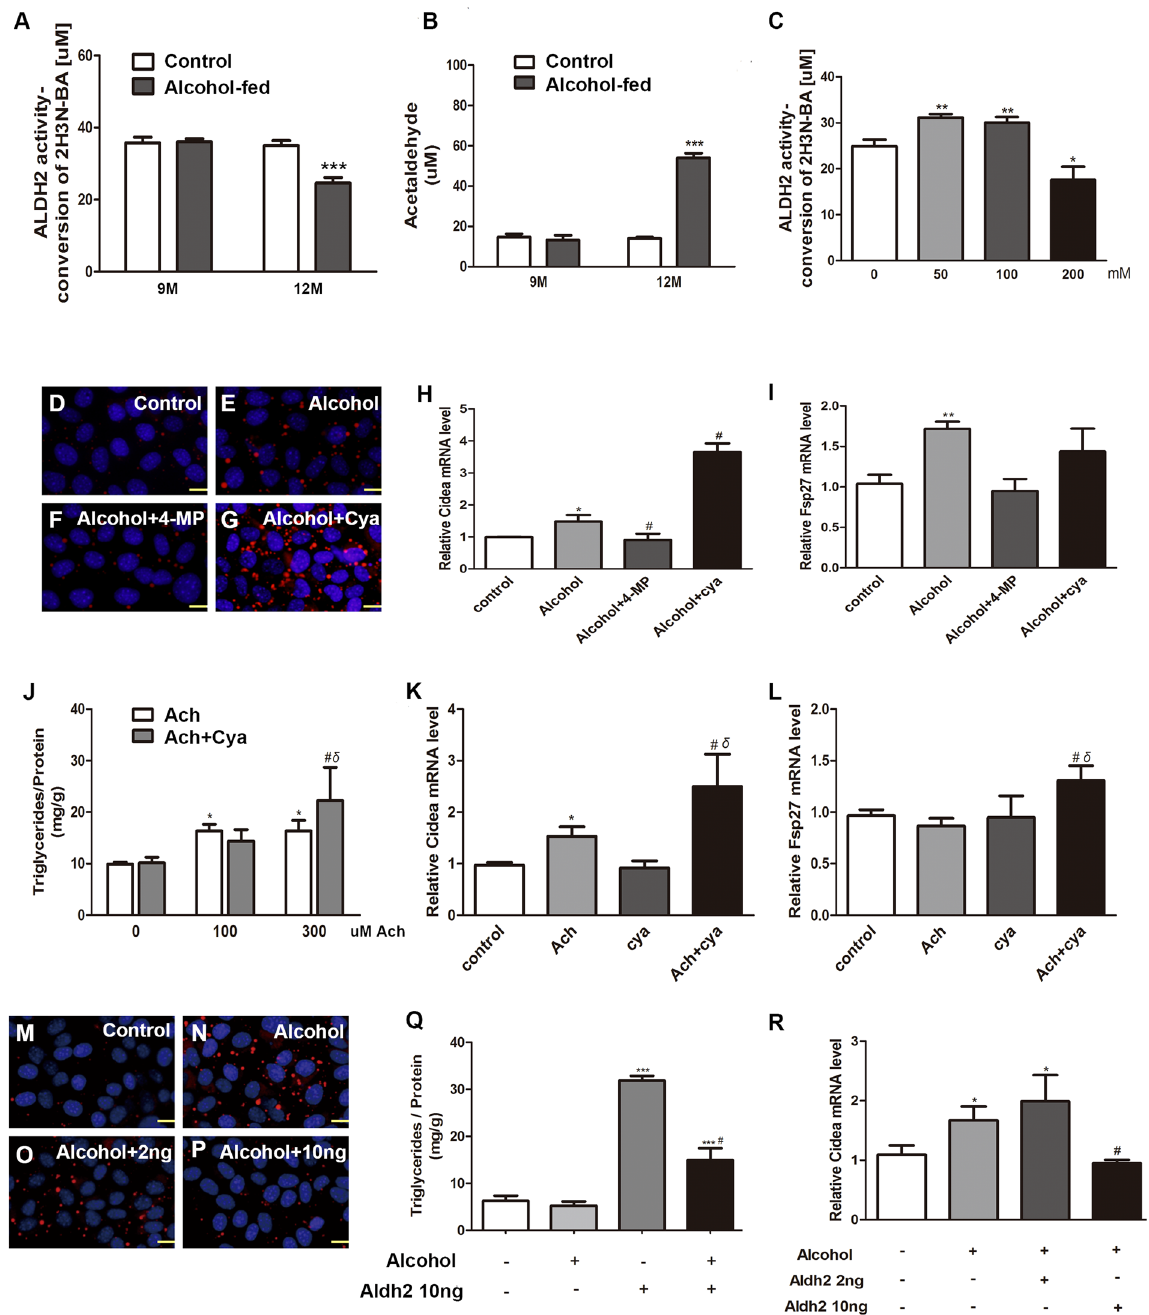
Figure 3. Cidea is directly induced by acetaldehyde but not by alcohol. ( A ) Activity of ALDH2 in liver tissue, *** p < 0.001 vs. control group. ( B ) Concentration of serum acetaldehyde, *** p < 0.001 vs. control group. ( C ) Activity of ALDH2 in AML12 cells were treated with different concentration alcohol, * p < 0.05; ** p < 0.01. AML12 cells were treated with alcohol, 4-methylpyrazole (0.1 mM 4-MP), or cyanamide (0.1 mM Cya) for 48 h. ( D – G ) Nile red staining (X200). ( H ) Cidea mRNA level and ( I ) Fsp27 mRNA level were measured. Means ± SD, n = 3, * p < 0.05 vs. control group; ** p < 0.01 vs. control group; # P < 0.05 vs. Alcohol group; NS, not significant. AML12 cells were treated with 100 uM and 300 uM of acetaldehyde or cyanamide (0.1 mM Cya). ( J ) Triglyceride contents were measured. Means ± SD, n = 3, * p < 0.05 vs. control group; # P < 0.05 vs. cya group; δ < 0.05 vs. 300 uM Ach group. AML12 cells were treated with 100 uM acetaldehyde or cyanamide (0.1 mM Cya) for 48 h. ( K ) Cidea mRNA level and ( L ) Fsp27 mRNA level were measured. Means ± SD, n = 3, * p < 0.05 vs. control group; # P < 0.05 vs. cya group; δ < 0.05 vs. Ach group. AML12 cells were treated with alcohol and 2 ng or 10 ng of the Aldh2 protein for 48 h. ( M – P ) Nile red staining (X200) and ( Q) Triglyceride contents and ( R ) qPCR analysis of the Cidea mRNA level were measured. Means ± SD, n = 3, * P < 0.05 vs. control group; *** P < 0.001 vs. control group; # P < 0.05 vs. Alcohol